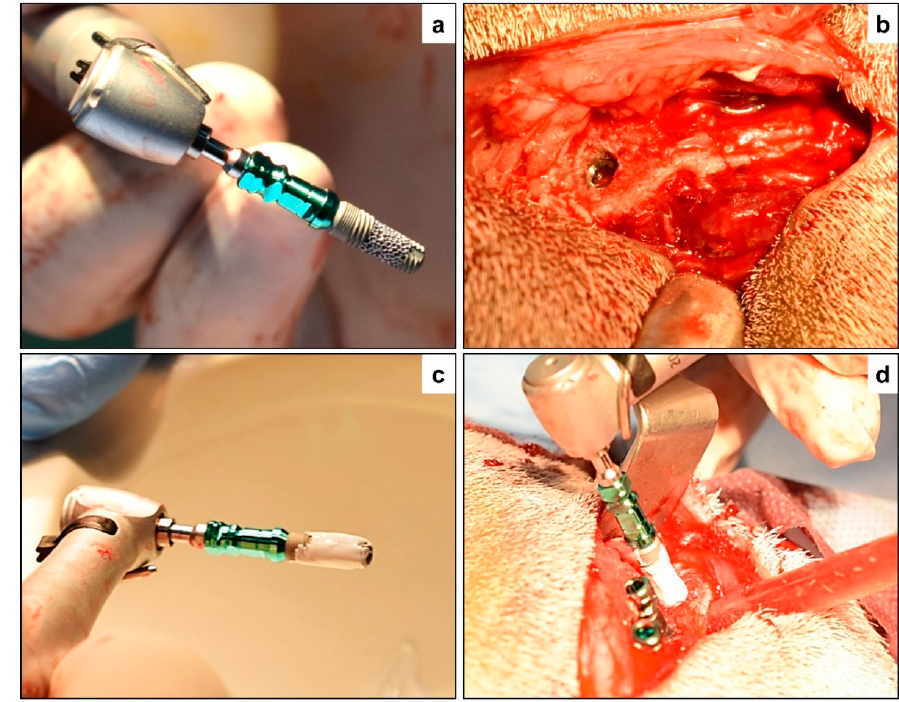
Figure 1. Surgical implant placement—( a ) Porous titanium implant (PTI) without biphasic calcium phosphate (BCP) augmentation prior to placement, and ( b ) after placement in the iliac crest of the study animal. ( c ) Porous titanium implant augmented with biphasic calcium phosphate (PTI + BCP),